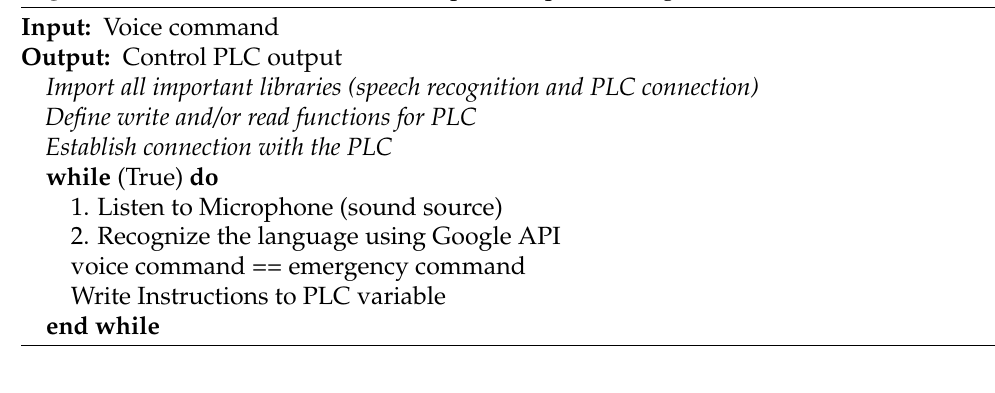
Algorithm 3 Voice command to PLC input via speech recognition